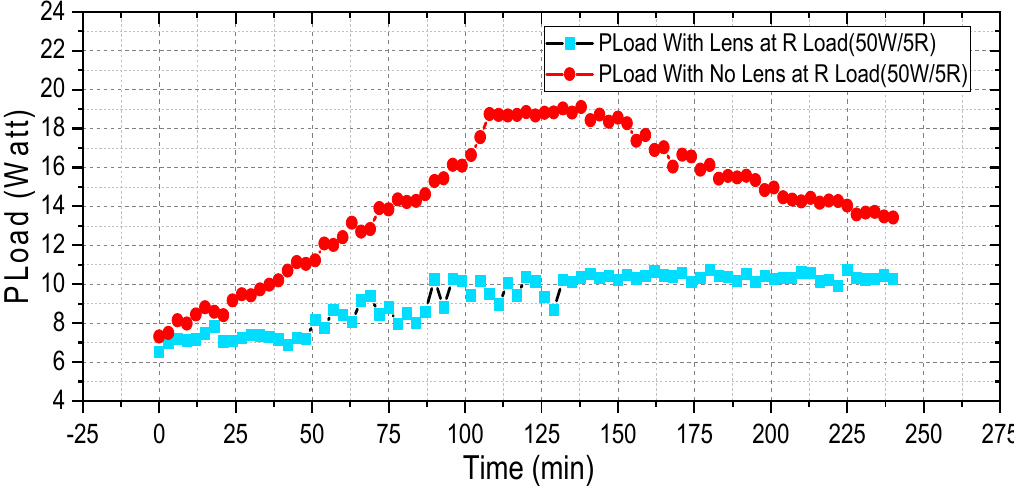
Figure 11. Power for both L-TEG and NL-TEG systems at load of (5 Ω /50 W).